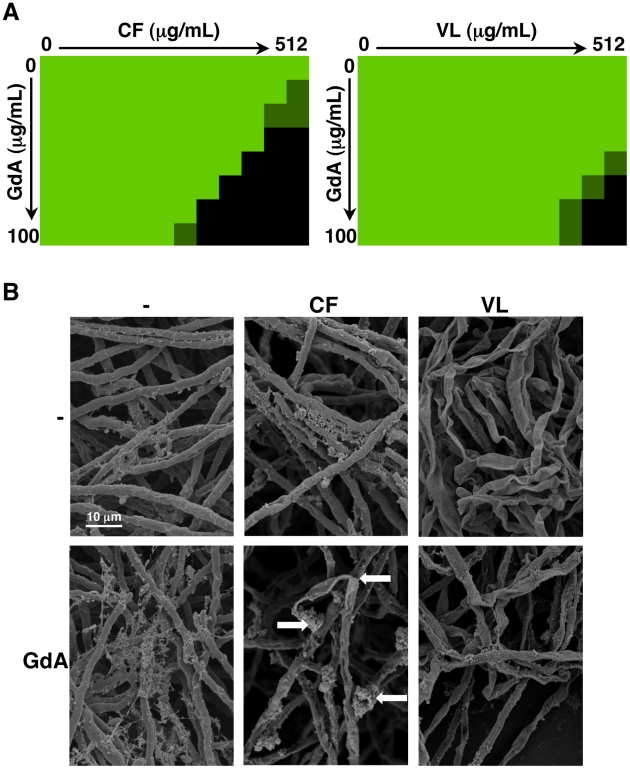
Pharmacological inhibition of Hsp90 enhances the efficacy of echinocandins and azoles against A. fumigatus biofilms and affects biofilm morphology.(A) A. fumigatus was grown in 96-well dishes in RPMI at 37°C. After 24 hours cells were washed with PBS to remove non-adherent cells and fresh medium was added with varying concentrations of the echinocandin caspofungin (CF), the azole voriconazole (VL), and the Hsp90 inhibitor geldanamycin (GdA) in a checkerboard format. Drug treatment was left on for 24 hours. Metabolic activity was measured as in Figure 1A. The FIC index was calculated as indicated in Table 2. Bright green represents growth above the MIC50, dull green represents growth at the MIC50, and black represents growth below the MIC50. (B) A. fumigatus cells were left untreated, or treated with 32 µg/mL CF or 256 µg/mL VL in the absence and presence of 50 µg/mL GdA for 24 hours. Following drug exposure, biofilms were fixed and imaged by scanning electron microscopy. Biofilms treated with antifungal show increased cellular damage in the presence of GdA. The white arrows indicate burst and broken hyphae in the biofilms treated with CF and GdA.